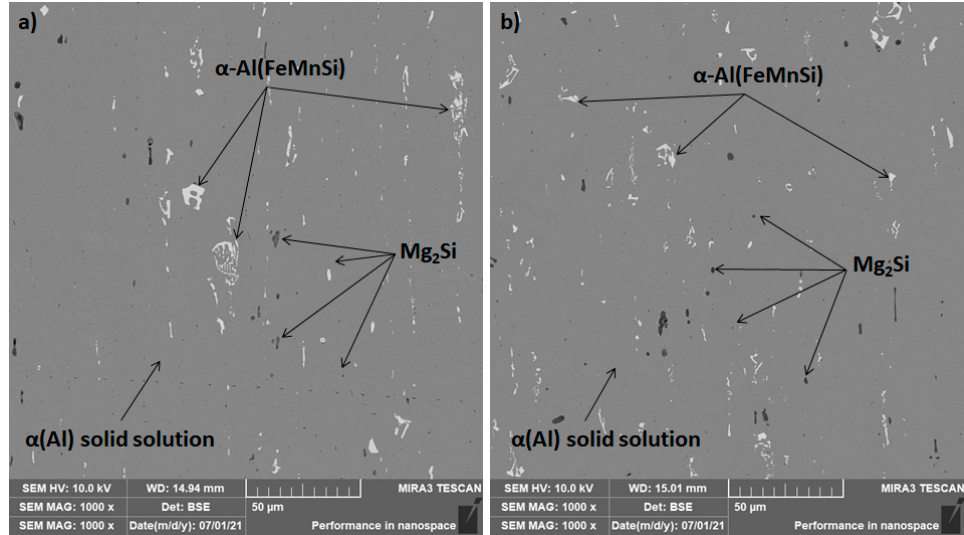
Figure 17. Microstructure of the HAZ after welding three beads with a preheating temperature of 150 °C at a distance 3 mm from the lower edge and 4 mm from the fusion line ( a ), and after artificial aging at 175 °C for 8 h ( b ) and 190 °C for 4 h.